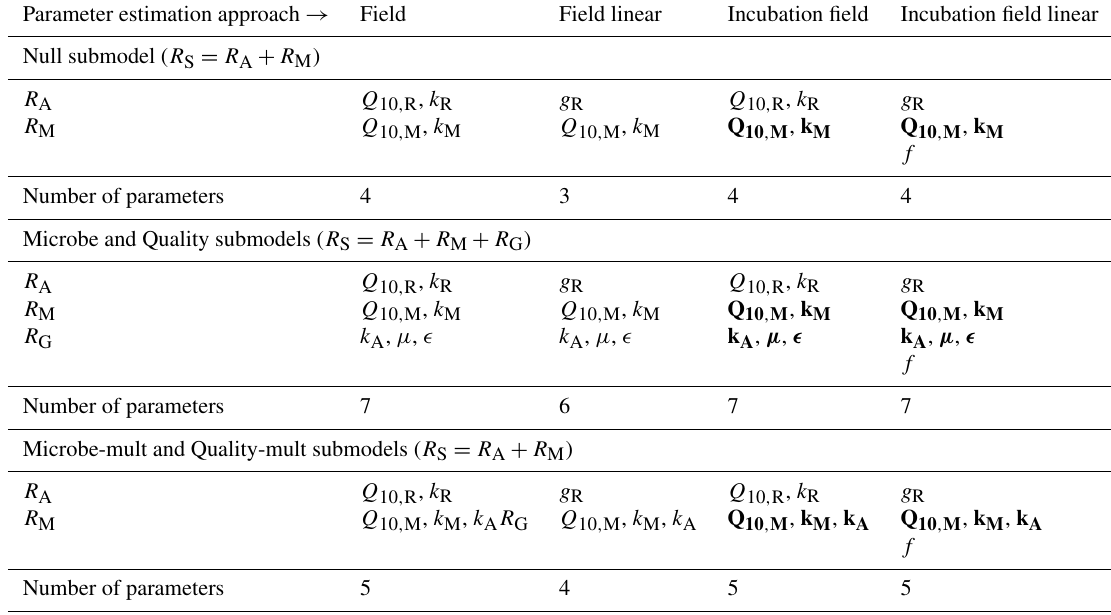
Table 4. Listing of parameters estimated with each submodel and parameter estimation approach. Parameters in bold-face font (incubation and incubation field linear approaches) were estimated from the incubation data first, followed by all remaining parameters with the field